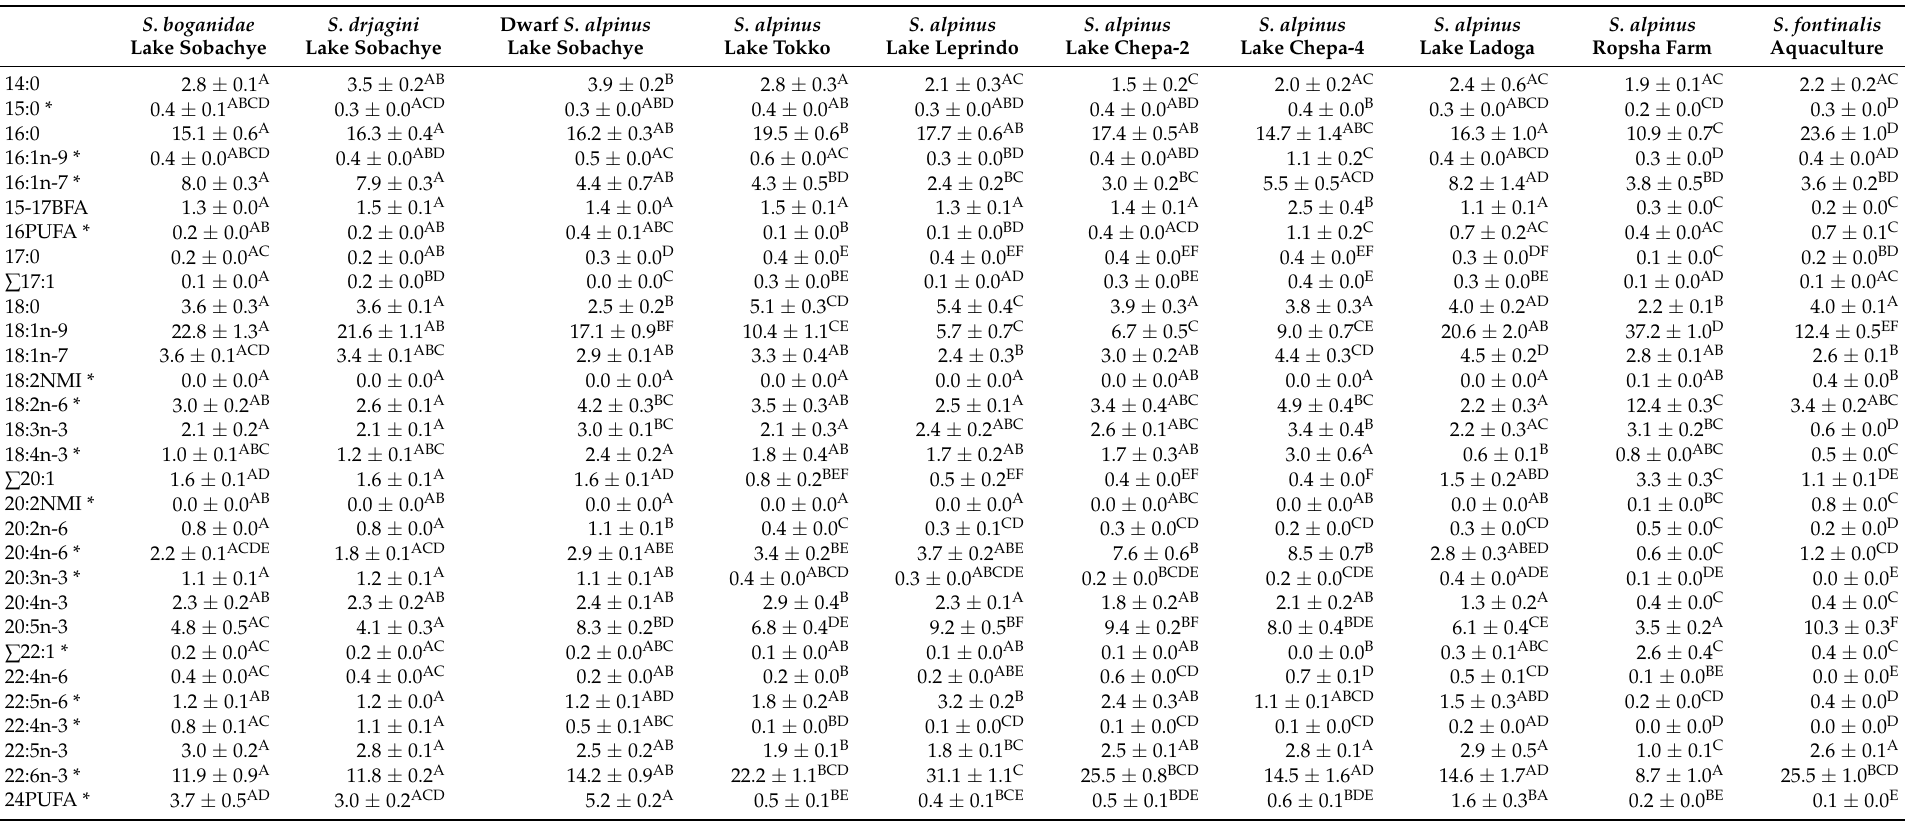
Table 3. Mean values of percentages of fatty acids (% of the total ± standard error) in muscle tissue of studied fish: boganid charr Salvelinus boganidae (number of samples, n = 14), Dryagin’s charr Salvelinus drjagini ( n = 16), goggle-eyed charr ( Salvelinus alpinus complex) ( n = 8), all from Lake Sobachye, Arctic charr Salvelinus alpinus from Lake Tokko ( n = 14), Lake Leprindo ( n = 7), Lake Chepa-2 ( n = 6), Lake Chepa-4 ( n = 7), Lake Ladoga ( n = 6) and Ropsha farm ( n = 7), brook trout Salvelinus fontinalis from the aquaculture of Timiryazev Academy ( n = 15). Normally distributed variables are compared by ANOVA and Tukey HSD post hoc test; the other variables are marked with asterisk * and are compared by Kruskal–Wallis test. Means labelled with the same letter are not significantly different at p < 0.05 according to the relevant